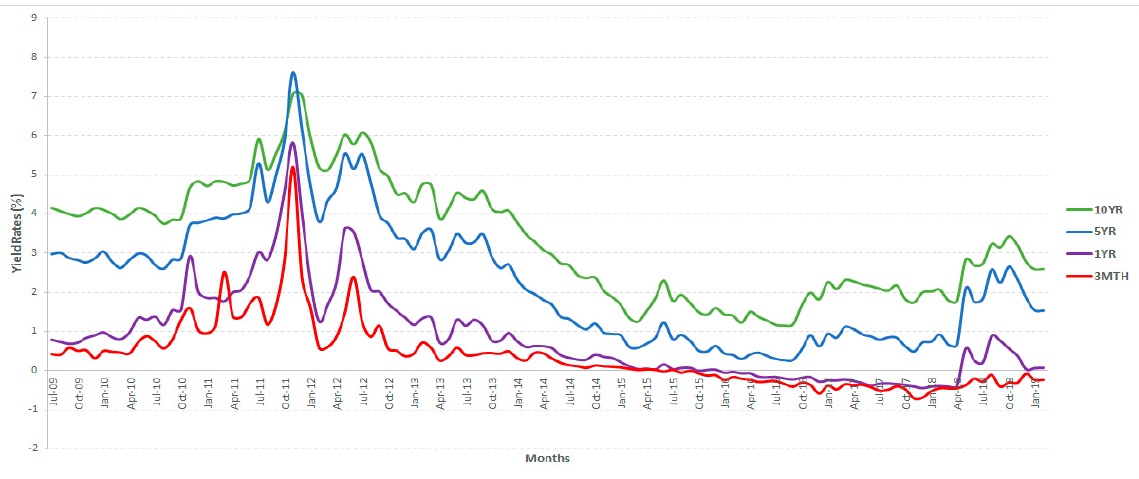
Figure 8. Government bond data plot for Italy.